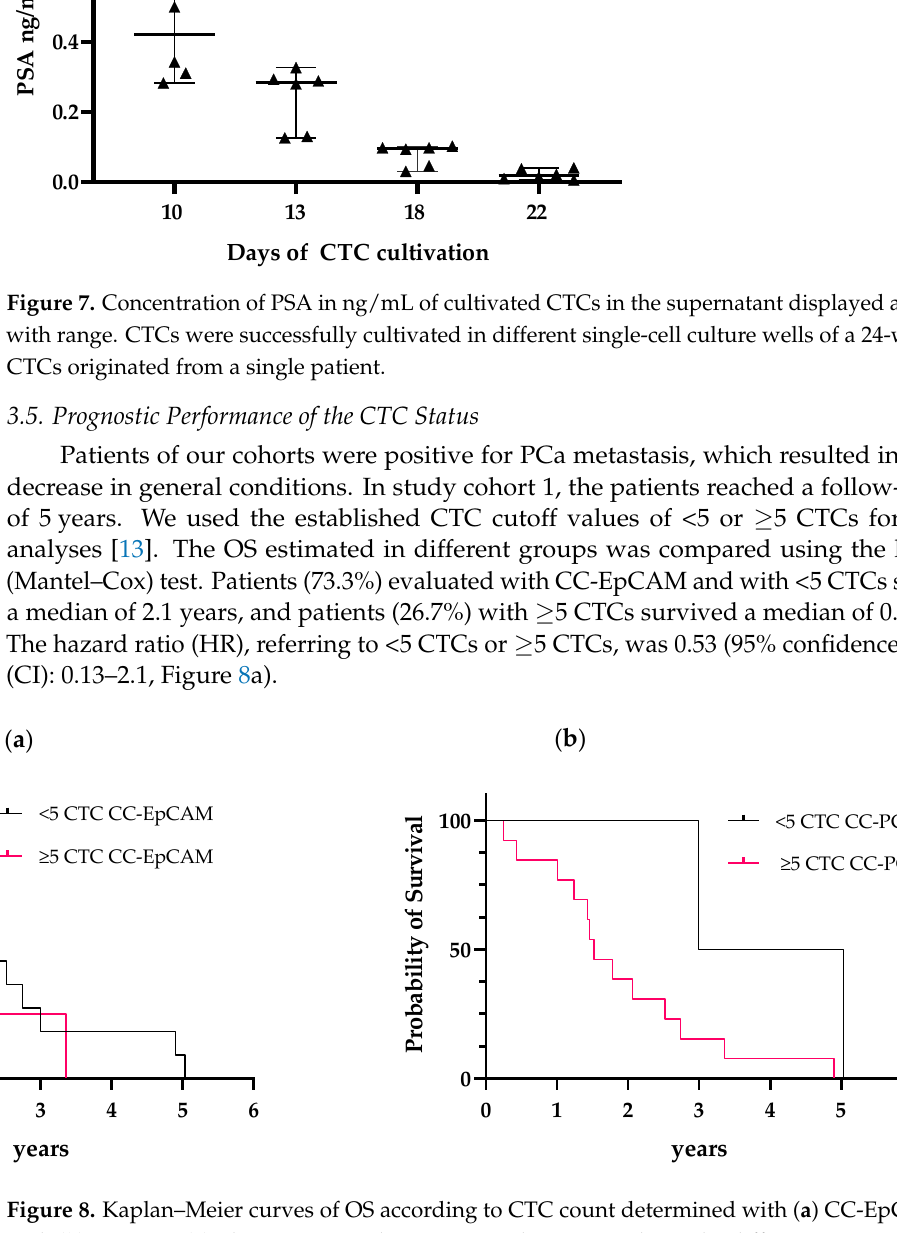
Figure 6. Representative images of cultivated CTCs. The CTCs display positive staining for ( a ) CK 8, 9 and 18, ( b ) Hoechst 33258 staining, ( c ) CD45 negativity and ( d ) overlay of images a, b, c. Scale bar presents 20 µm. Brightfield images of growing CTCs ( e , f ).